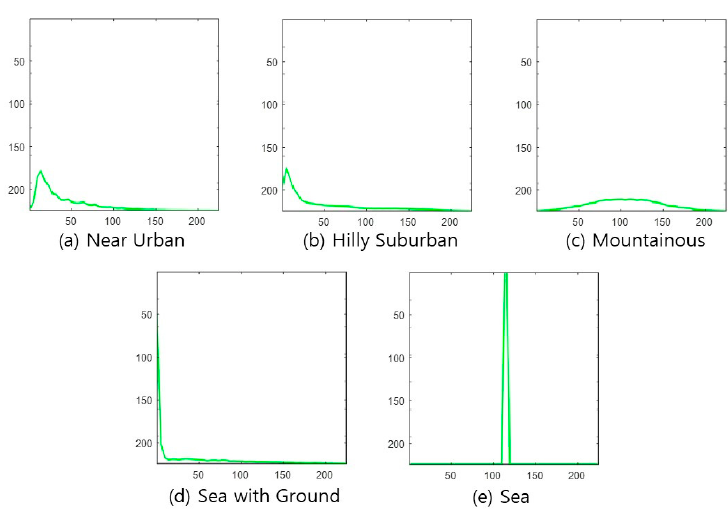
Figure 4. Example of relative-altitude PMF for each topography class.